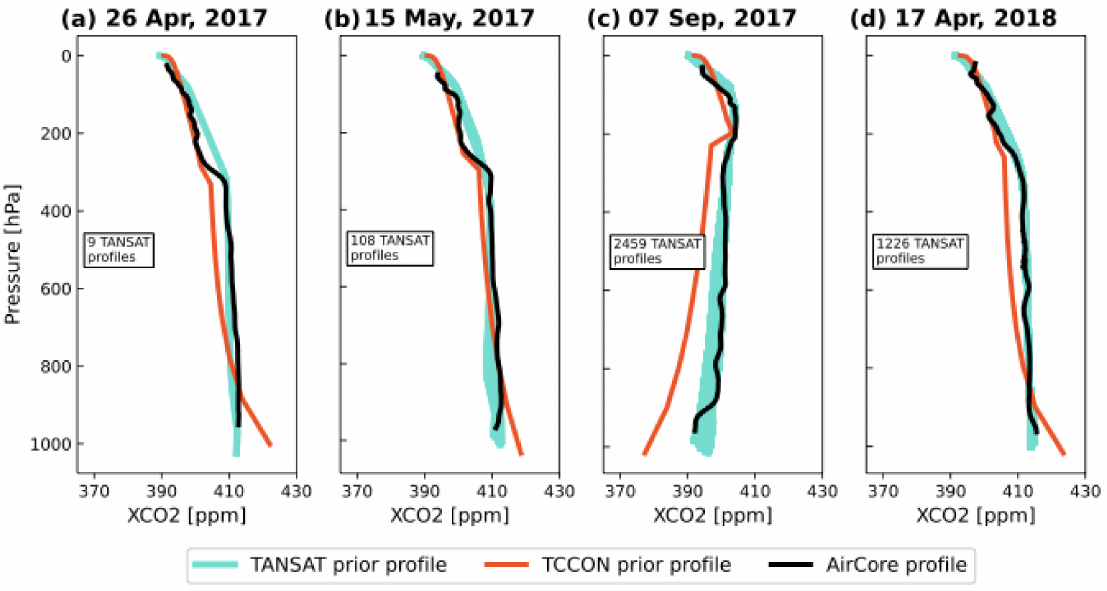
Figure 7. TanSat prior CO 2 profiles (turquoise), TCCON prior CO 2 profiles (red) and measured CO 2 profiles from the AirCore (black) for ( a ) 26 April 2017; ( b ) 15 May 2017; ( c ) 7 September 2017; ( d ) 17 April 2018. TanSat profiles are collected from retrievals within ± 2 days from the AirCore date with the spatial co-location criteria of ± 5 ◦ from the Sodankylä TCCON site. The number of co-located TanSat profiles is indicated in each